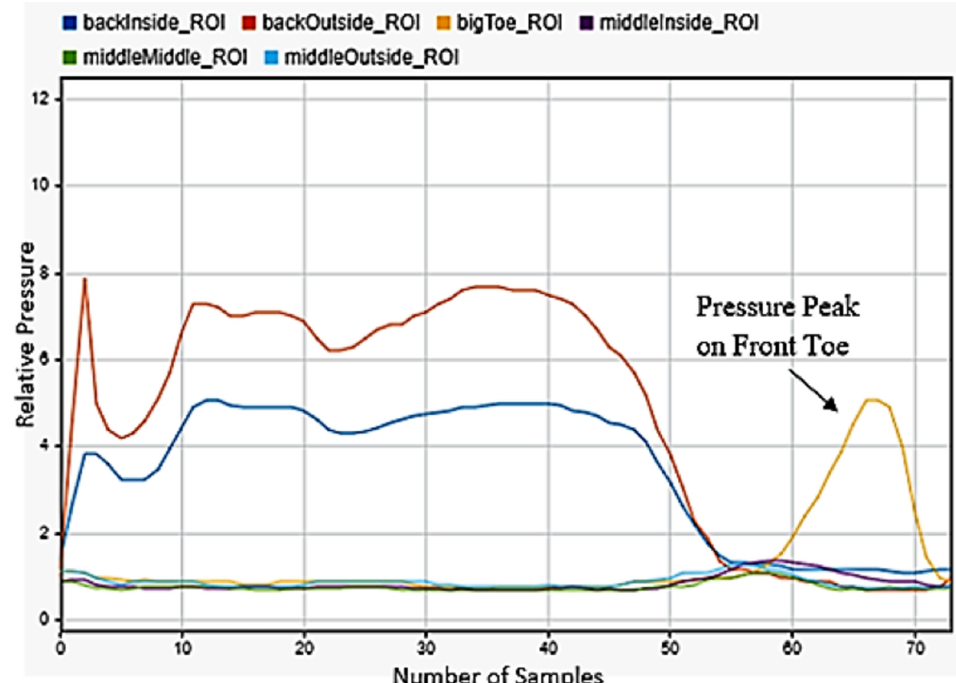
Figure 14. Falling forwards sensor data for the left foot.